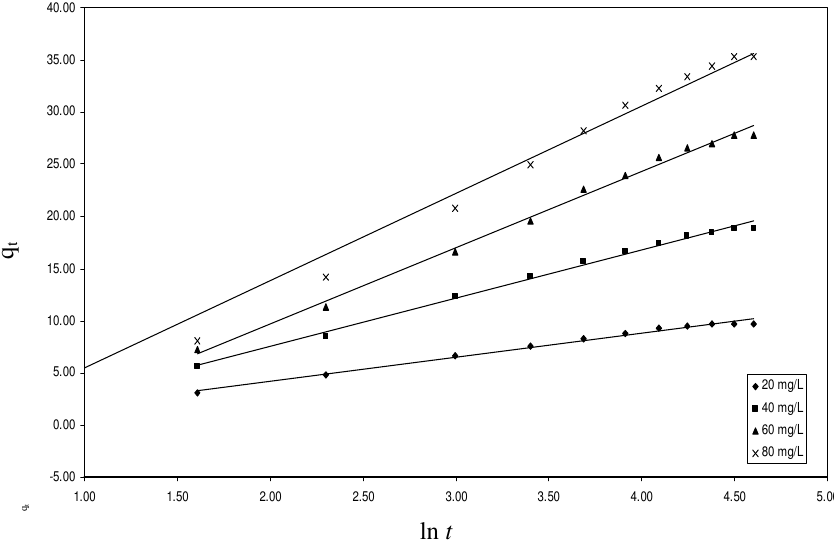
Figure 6. Elovich plot-initial concentration variation